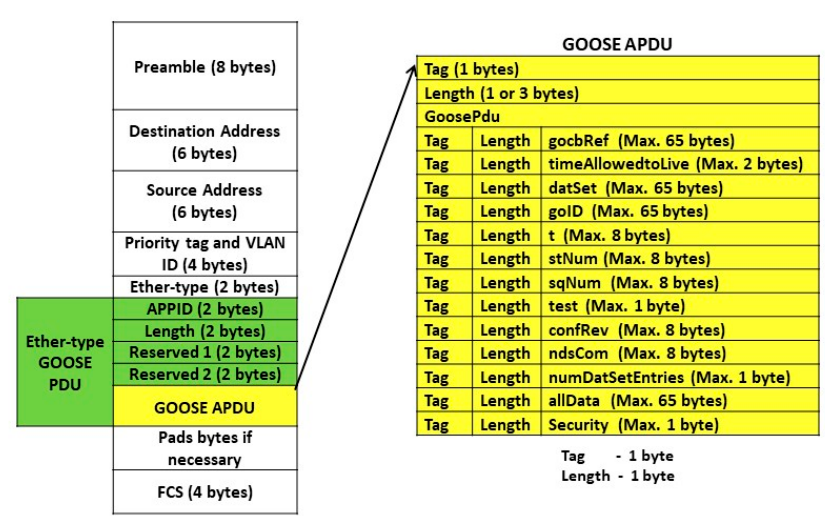
Figure 4. TLV format of pay load fields of GOOSE and Sample Values.